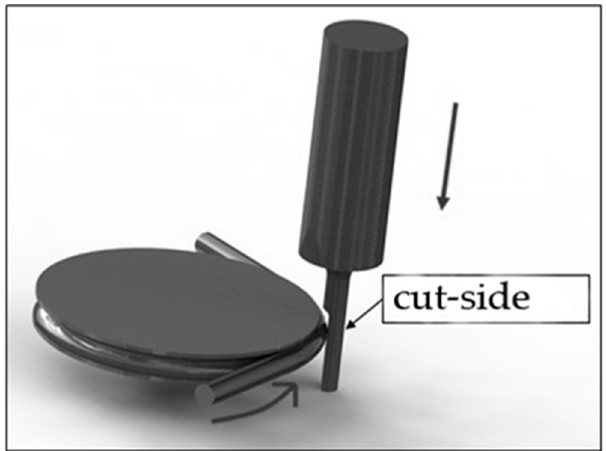
Figure 14. Cut-side shaped micro-tool process by WEDG.